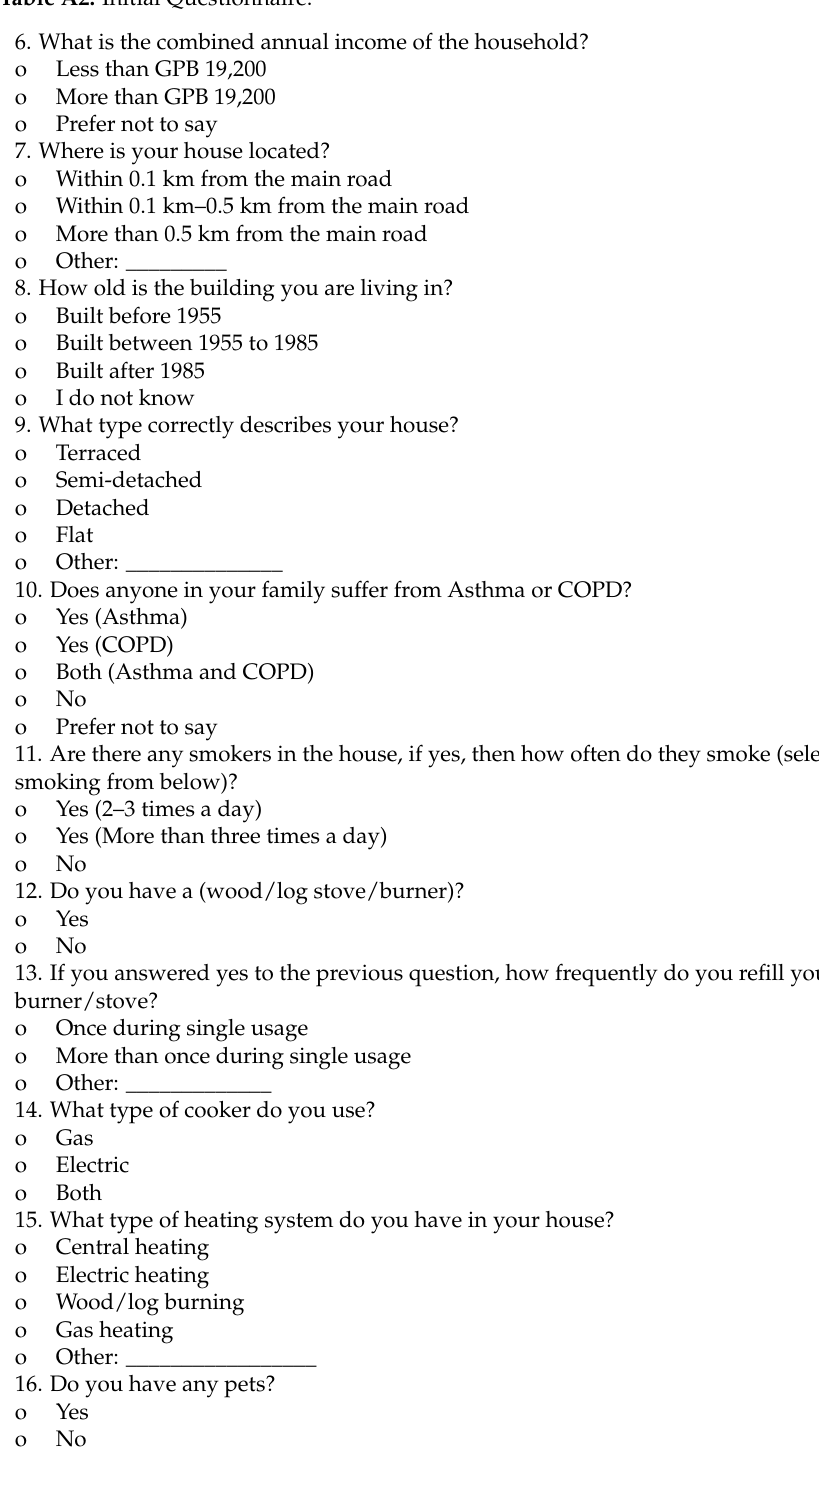
Table A2. Initial